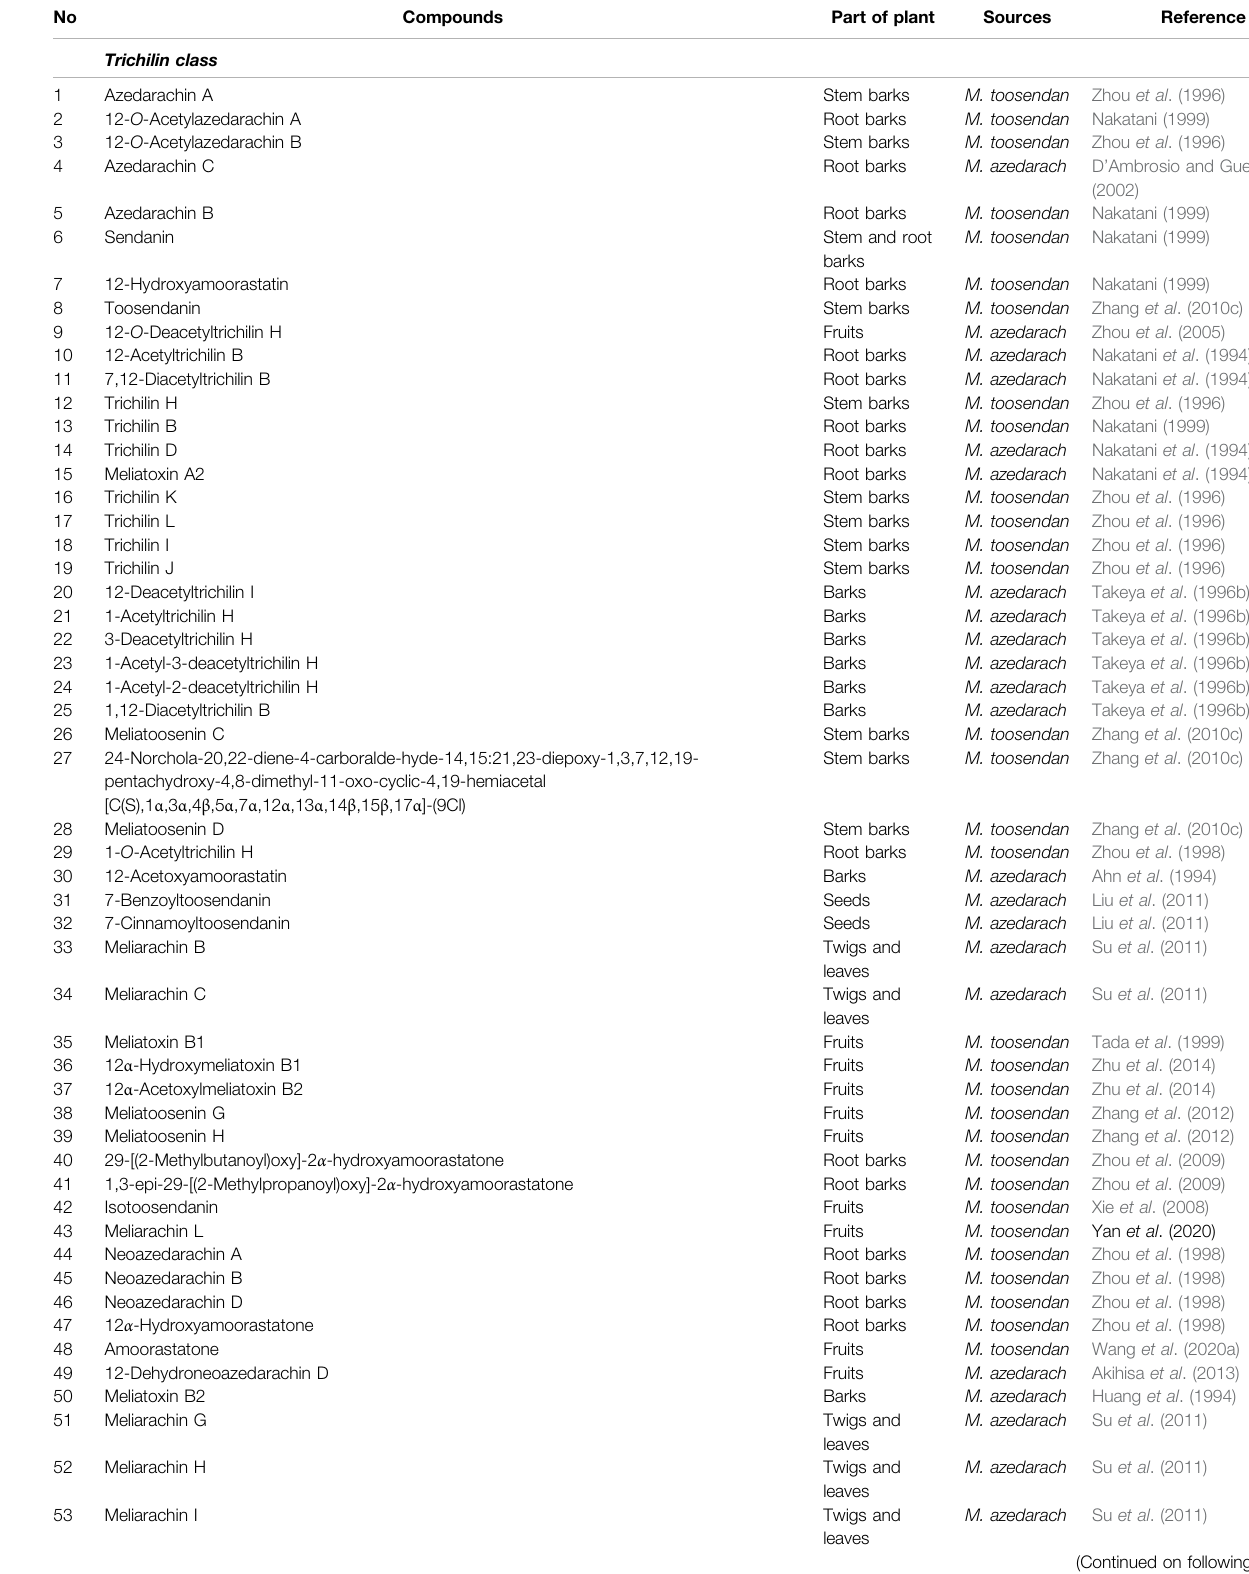
TABLE 1 | Classi fi cations and sources of limonoids isolated from genus Melia .